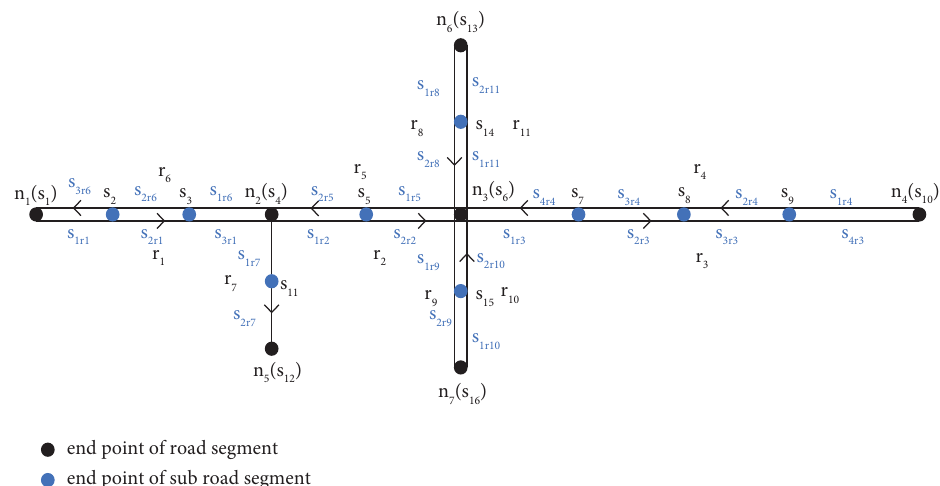
Figure 2: Illustrative diagram of fne-grained road network